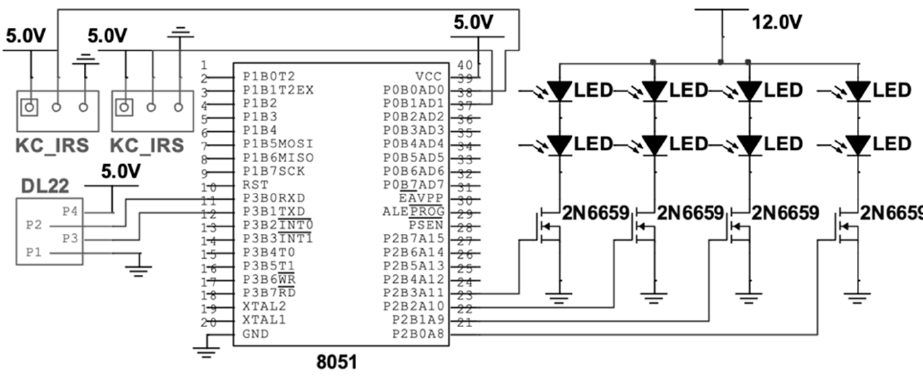
Figure 4. Circuit Figure 4. Circuit schematics. Figure 4. Circuit schematics.